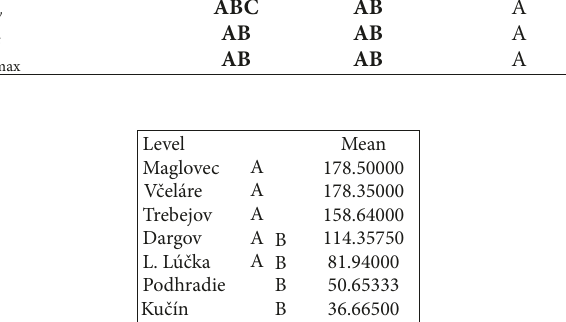
Figure 8: Means comparisons L < 0; 40 > v